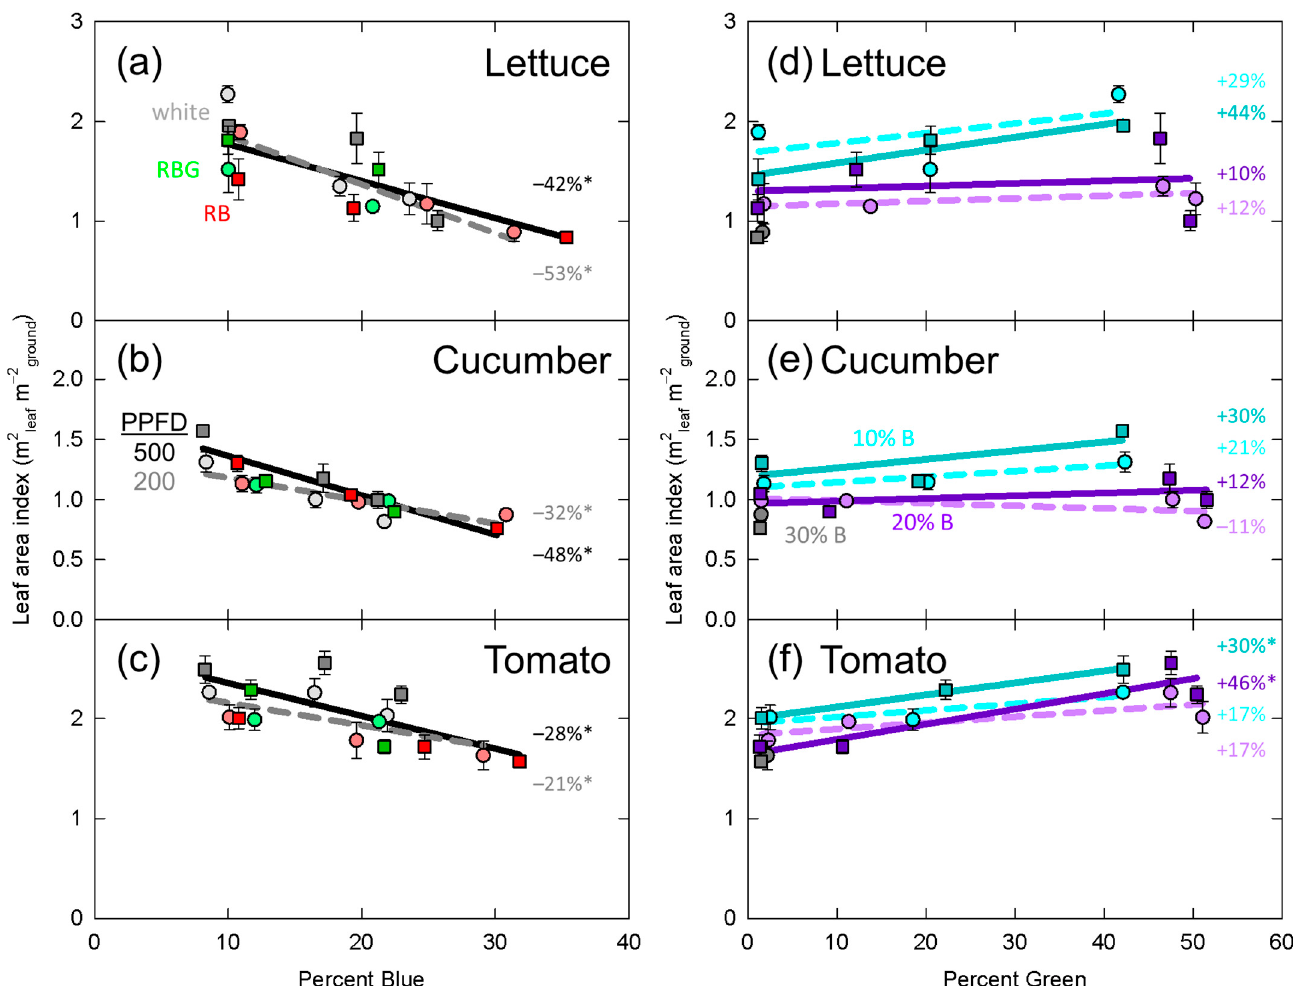
Figure 4. Effect of percent blue on leaf area index in (a) lettuce, (b) cucumber, and (c) tomato; and effect of percent green on leaf area index in (d) lettuce, (e) cucumber, and (f) tomato. * represents a significant effect of percent blue or percent green at the p < 0.05 level. See Figure 3 for the meaning of specific labels. Error bars represent normalized standard error of n=3 replicates.